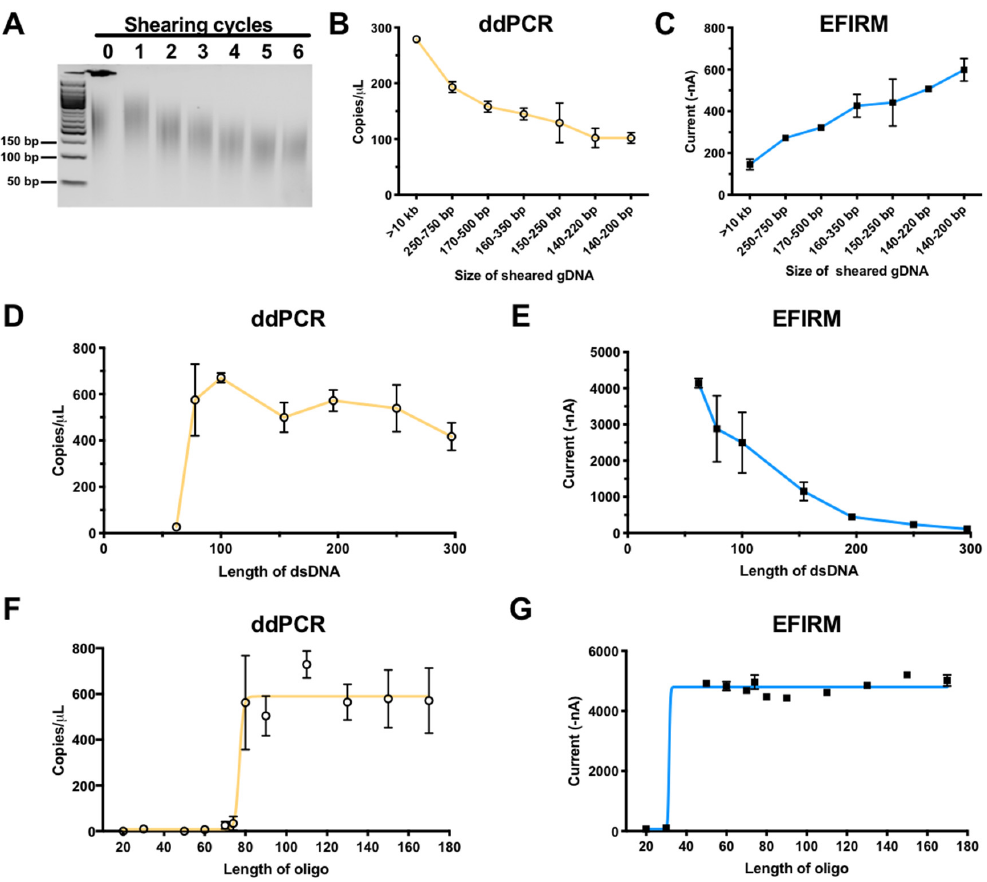
Figure 2. Comparison of EFIRM and ddPCR performance using sheared gDNA, dsDNA, and oligomer harboring L858R mutation. ( A ) Genomic DNA extracted from H1975 cell line was subjected to 0–6 shearing cycles with a Covaris focused ultrasonicator and was analyzed with agarose gel. Subsequently, L858R signal was detected in these samples using ddPCR (orange) ( B ) and EFIRM (blue) ( C ). A serial of PCR products of the size of 62, 78, 100, 154, 196, 250, and 297 bp with L858R mutation in similar concentrations were tested with ddPCR ( D ) and EFIRM L858R assay ( E ). Oligonucleotides (20 to 170-mer), with the L858R EGFR mutation in the center, were designed and synthesized. The ability of ddPCR (orange, F ) and EFIRM (blue, G ) to detect signals for those oligonucleotides was assessed. Ten pmol of each target was used for the EFIRM assay.